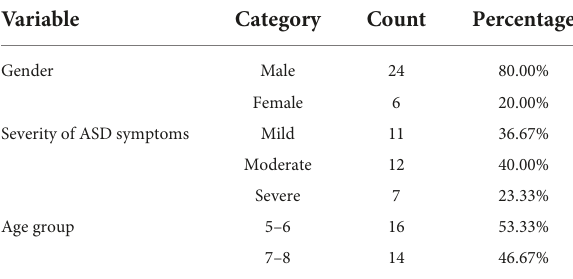
TABLE 1 Descriptive statistical analysis